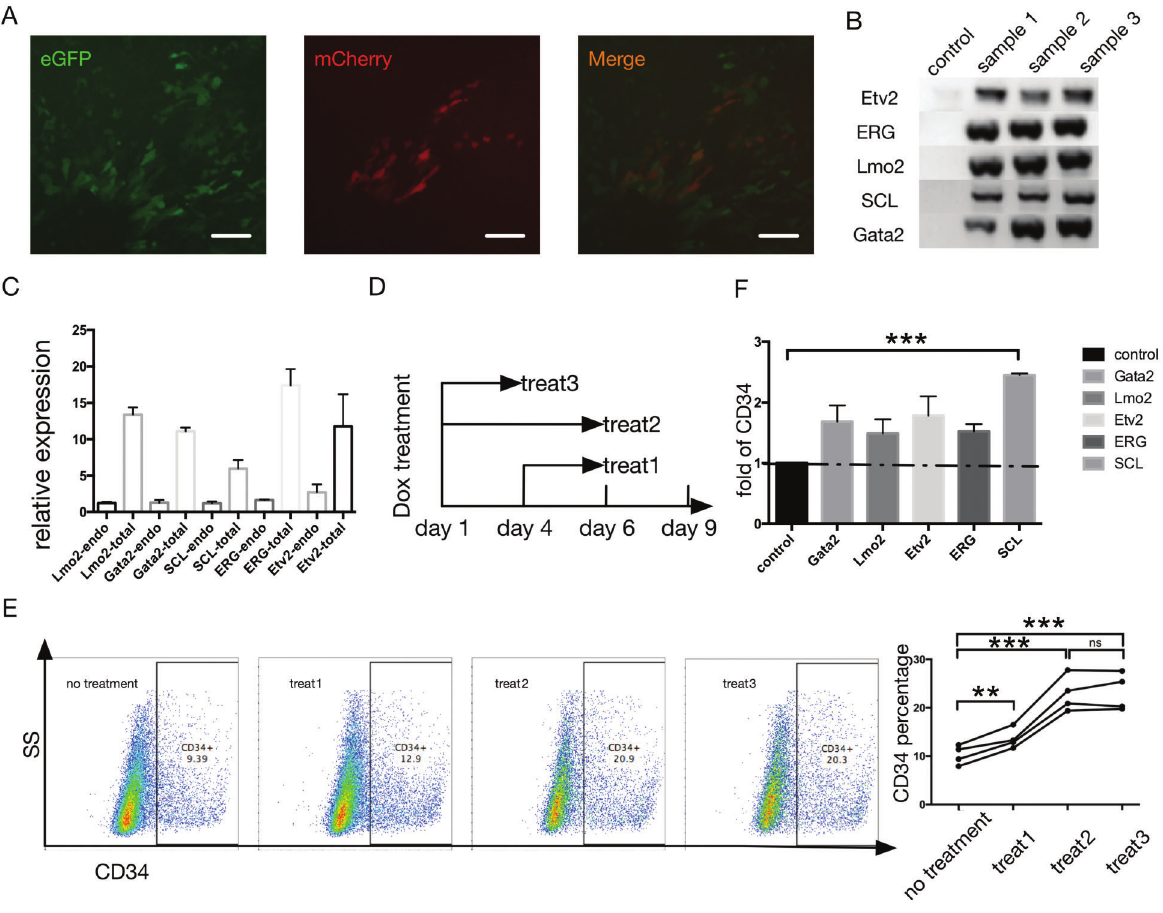
Figure 4. Induced expression of hematopoietic transcription factors enhanced hematopoietic differentiation. A, H1 cells transduced by Lv-ef1 a -eGFP-tre-mCherry were green. Merged cells were transduced by both Lv-ef1 a -rtTA-IRES-puro and Lv-ef1 a -eGFP-tre-mCherry. The expression of mCherry (red) was induced after 48 h of Dox treatment. Scale bar=100 m m. B, Genomic PCR was used to con fi rm the exogenous genes integration. Control was H1 cells transduced by mCherry (Lv-ef1 a -eGFP-tre-mCherry). C, Samples were treated with 1 m g/mL doxycycline (Dox) for 48 h. qPCR was used to con fi rm the relative expression of endogenous and exogenous genes. endo: endogenous expression; total: endogenous plus exogenous expression. Data are reported as means ± SE (n X 3). D, Strategies